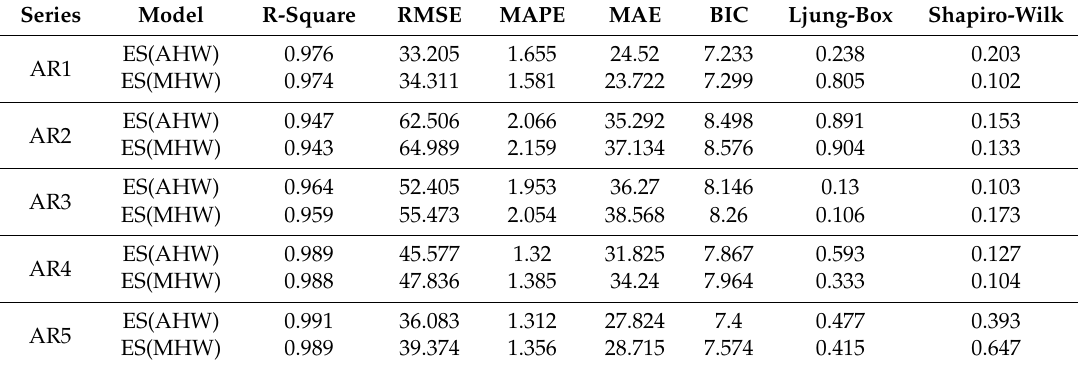
Table 3. Model fit statistics and residual statistics for exponential